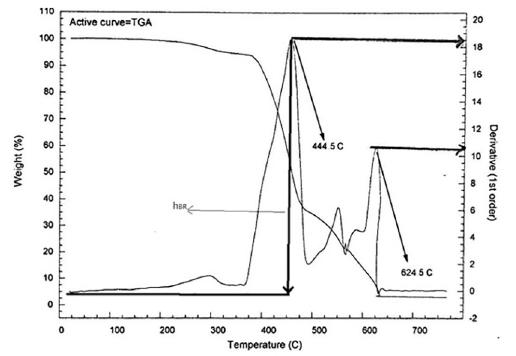
Figure 1. TG-DTG curves of BR/SBR rubber specimens aged for 30 days.